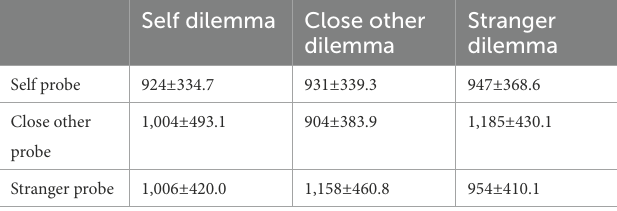
TABLE 2 Descriptive statistics for the response time of probe stage ( M ± SD).